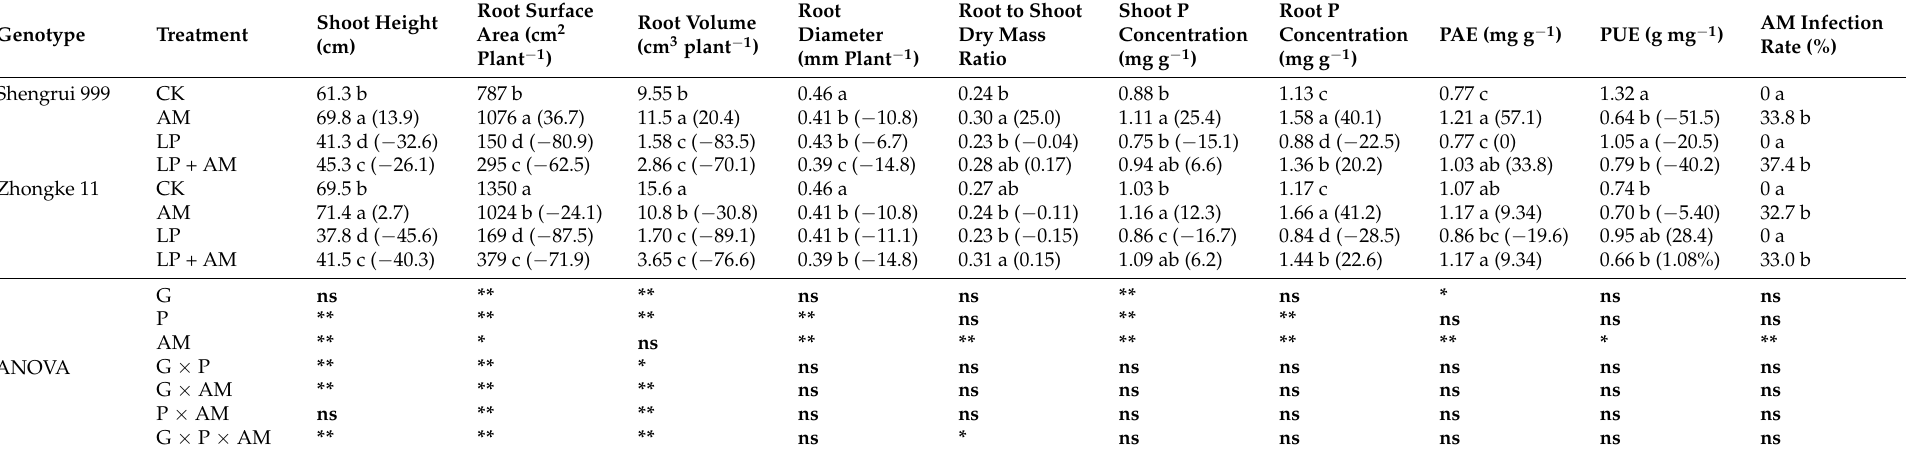
Table 1. Treatment effects on shoot height, root surface area, root volume, root diameter, root–shoot dry mass ratio, shoot and root P concentration, PAE, PUE, and AM infection rate of two maize genotypes (Shengrui 999 and Zhongke 11) grown for 53 days in soil-filled